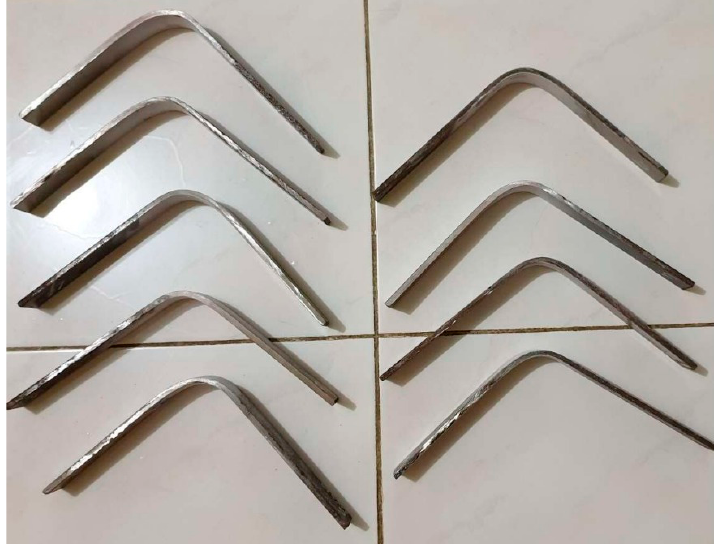
Figure 7. Samples of flexural test. Table 7. The analysis of variance for the flexural strength of SS316 and low-carbon steel weld joints. Seq.